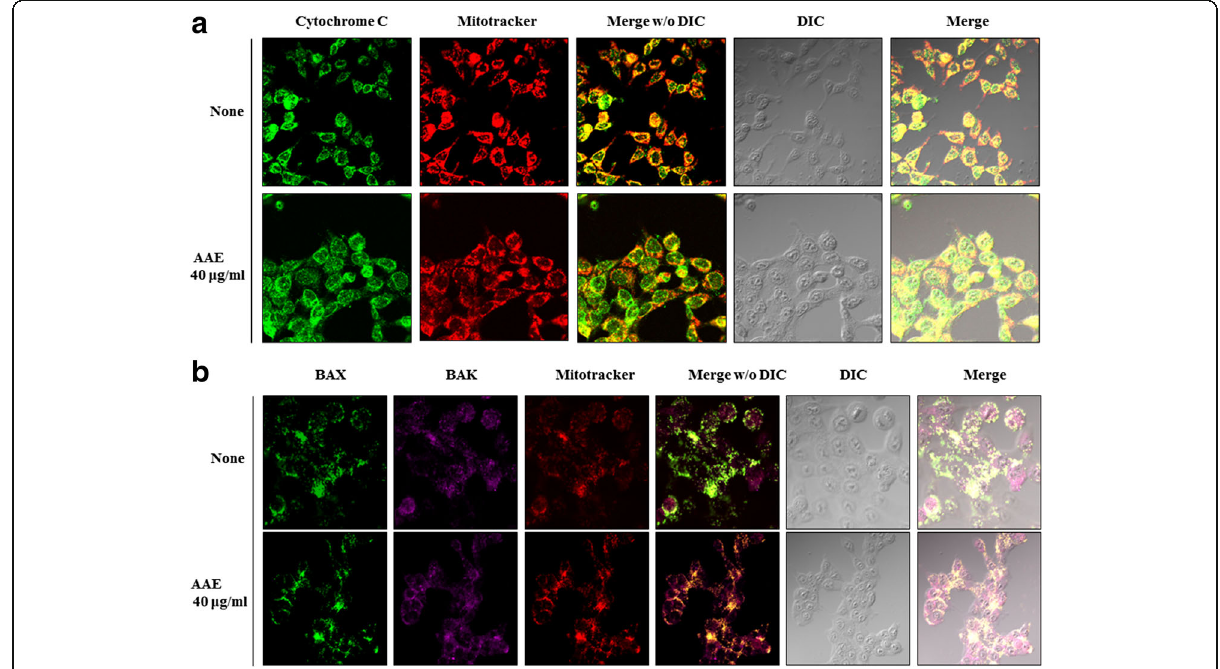
Fig. 4 AAE regulates cytochrome c translocation to the cytoplasm and Bax translocation to the mitochondrial membrane. a AAE regulated cytochrome C translocation from mitochondria to cytosol. Also, ( b ) AAE induced BAX activation from mitochondria outer membrane to cytosol and BAX/BAK oligomerization. Cell were treated with AAE (40ìg/ml) for 24 h. Target protein and mitochondria were stained with fluorescence lag and cell locations were indicated using a DIC